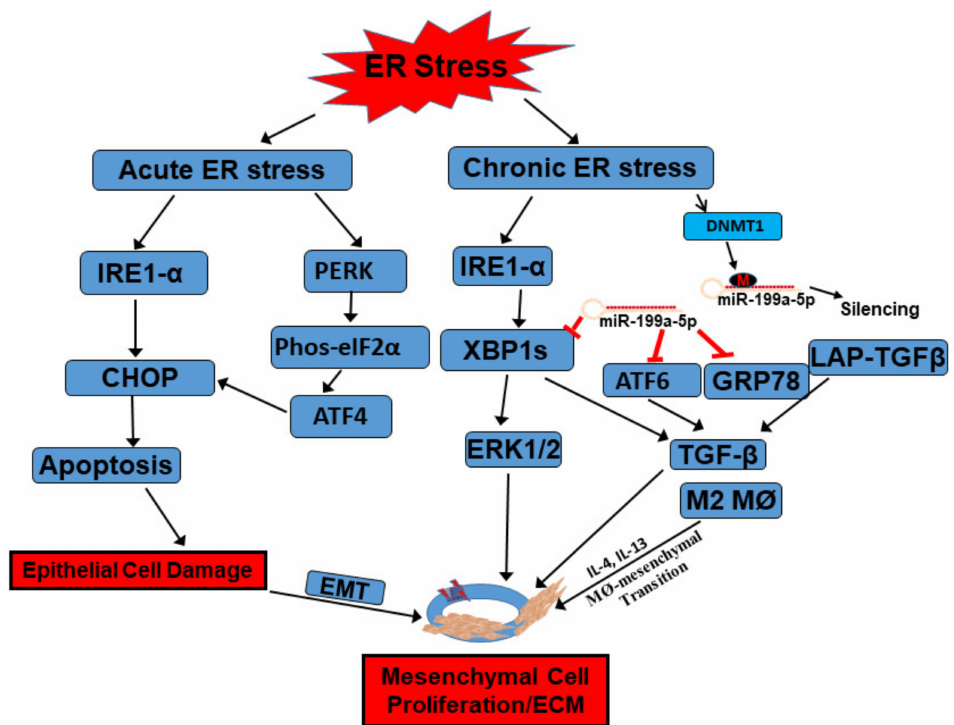
Figure 2. Functions of the UPR in the development of intestinal fibrosis in Crohn’s disease. When intestinal epithelial cells (IECs) are subject to acute ER stress, ER stress sensors IRE1 α and PERK can be activated with detached association from binding partner GRP78. Downstream signaling, including CHOP and eIF2 α /ATF4, are further activated to induce apoptosis in IECs. Meanwhile, inflammatory cytokines, such as IL-4 and IL-13, induced activation of macrophages (M2) as well as macrophage-to-mesenchymal transition. TGF- β can be secreted from this transition to further activate mesenchymal cells, such as subepithelial myofibroblasts, to proliferate and induce extracellular matrix protein production. When the intestine is subject to chronic inflammation-induced ER stress, IRE1 α catalyzes non-canonical splicing of X-box binding protein 1 (XBP1) mRNA into the constitutively active form XBP1s, which activates ERK1/2 to stimulate mesenchymal cell proliferation. The increased UPR is also associated with increased silencing of miR-199a-5p by DNMT1-mediated promoter hypermethylation. At rest condition, miR-199a-5p targets different ER stressors, including GRP78, ATF6, and XBP1s, through complementary binding to their promoter regions for their degradation. ATF6 and XBP1 both serve as transcription factors and activate ER stress-induced myofibroblasts activation through upregulation of TGF- β and excess ECM production. GRP78 can bind to latent associated peptide (LAP)-TGF β to activate TGF- β . All these factors can finally contribute to the development of intestinal fibrosis. Refer to context for